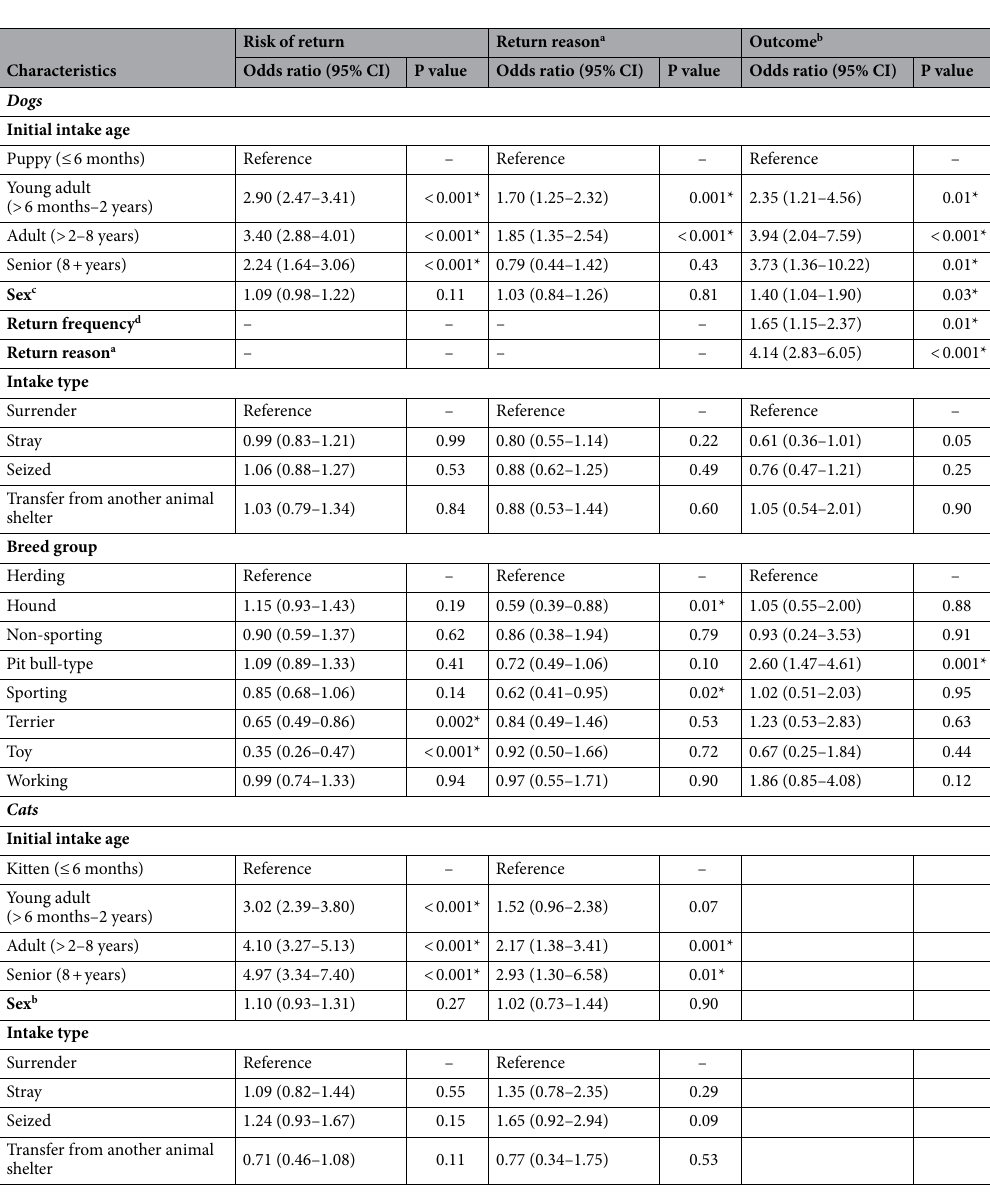
Table 2. Logistic regression models describing the risk of return and euthanasia based on animal characteristics. *Denotes statistical significance ( p < 0.05). a Owner-based return reasons were coded as the reference category. b Reflects the most recent outcome for animals that were returned multiple times. c Females were coded as the reference category. d Return frequency was coded as dichotomous based on animals who were returned once and animals who were returned more than once. Single returns were coded as the reference